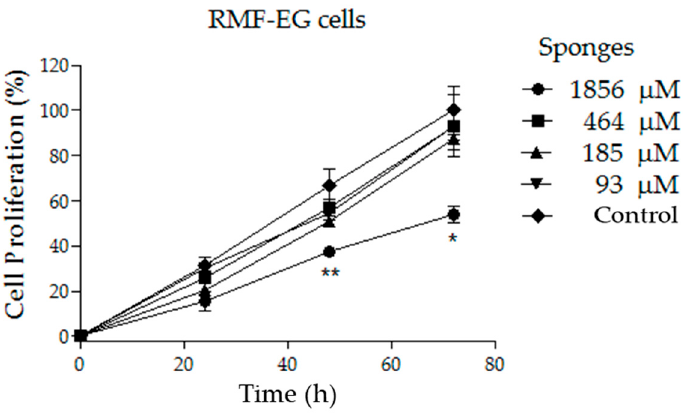
Figure 5. Proliferation curve of fibroblast (RMF-EG cell line) exposed to di ff erent doses of sponges of LMWHA / PArg = 2.4. Significant di ff erences were obtained when comparing the values from each time with respect to the respective control value (mean ± SD, n = 3) and are indicated (** p ≤ 0.01, * p ≤ 0.05).